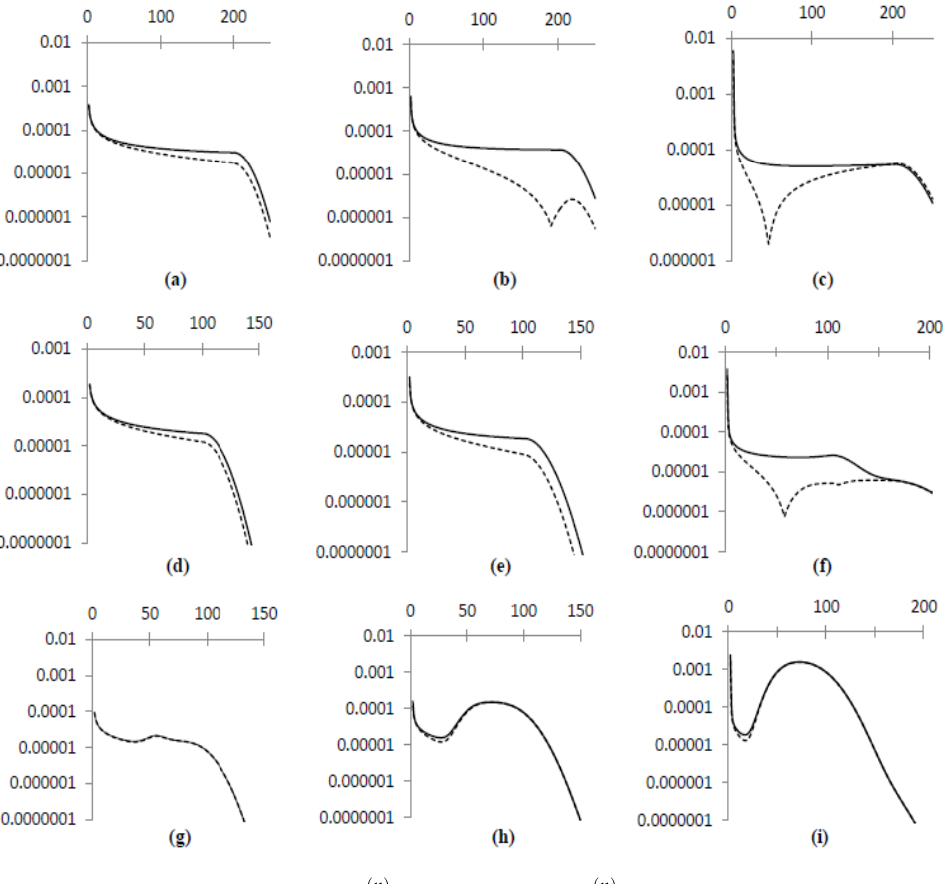
( n ) ( n ) ( ) n  ( ) n  (solid lines) and ε (dashed lines) as functions of n : (solid lines) and (dashed lines) as functions of n : ( a ) 3 4 3 4